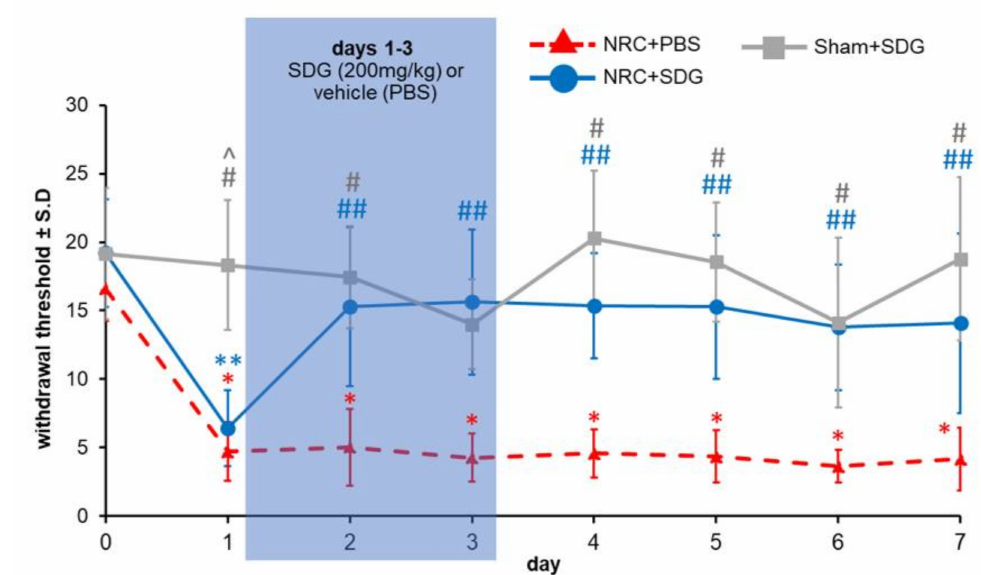
Figure 2. One day after a painful nerve root compression (NRC), withdrawal thresholds are significantly lower (i.e., more sensitive) than pre-injury baseline levels (day 0) regardless of whether they receive vehicle (* p < 0.0001) or SDG (** p < 0.0001) treatment. Withdrawal thresholds for the PBS vehicle group remain significantly lower (* p < 0.0001) than their baseline through day 7, while treatment with SDG significantly increases ( ## p < 0.02) thresholds over vehicle as early as day 2, lasting until day 7. Thresholds after sham are significantly higher than both vehicle ( # p < 0.0004) and SDG( ˆ p < 0.0006) treatment at day 1 and significantly higher (# p < 0.016) than vehicle thresholds after day